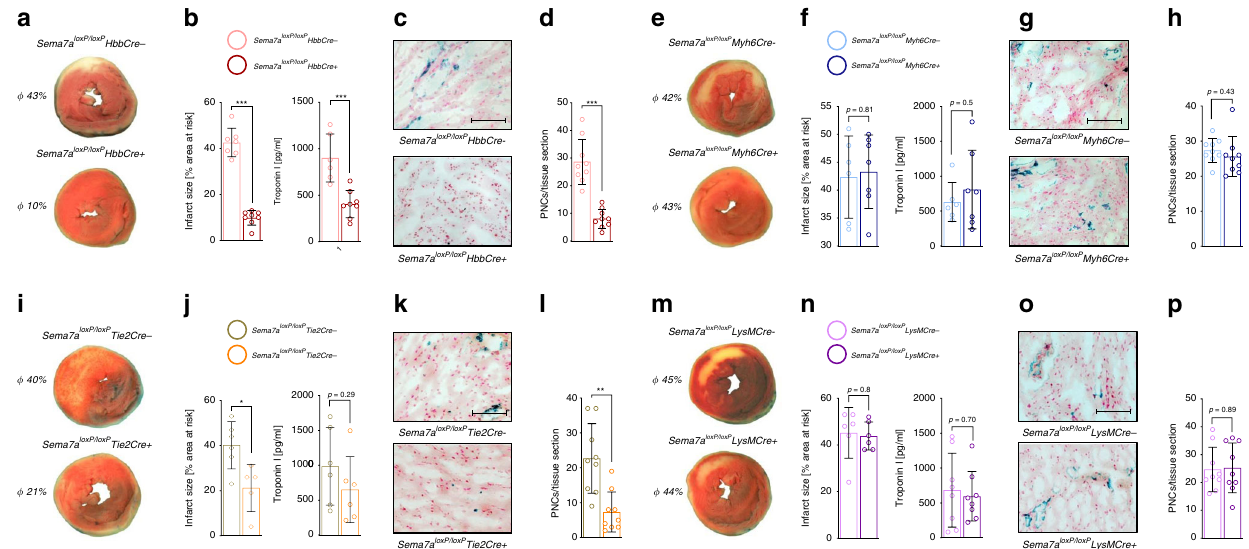
Fig. 4 RBC-derived Sema7a drives PNC formation and aggravates MIRI. Sema7a loxP/loxP HBBCre + , Sema7a loxP/loxP Myh6Cre + , Sema7a loxP/loxP Tie2Cre + , and Sema7a loxP/loxP LysMCre + animals or littermate controls were exposed to 60 min of ischemia and 120 min reperfusion. a Representative TTC-stained slices of myocardial tissue showing infarcted area (blue/dark = retrograde Evans blue staining; red and white = AAR, white = infarcted tissue) in Sema7a loxP/loxP HBBCre + or littermate controls with b systematic evaluation of infarct sizes ( n = 7;8) and correlating troponin I plasma levels ( n = 6;8). c Representative histology sections (scale bar 100 µ m) of Sema7a loxP/loxP HBBCre + animals or littermate controls and d number of PNCs counted from myocardial AAR sections in Sema7a loxP/loxP HBBCre + animals or littermate controls ( n = 9/group). e Representative TTC-stained slices of myocardial tissue showing infarcted area in Sema7a loxP/loxP Myh6Cre + or littermate controls with f systematic evaluation of infarct sizes and correlating troponin I plasma levels ( n = 6;7). g Representative histological sections of Sema7a loxP/loxP Myh6Cre + animals or littermate controls (scale bar 100 µ m) and h number of PNCs counted in myocardial tissue sections of Sema7a loxP/loxP Myh6Cre + animals or littermate controls ( n = 9/group). i Representative TTC-stained heart slices showing myocardial infarcts in Sema7a loxP/loxP Tie2Cre + or littermate controls with j systematic evaluation of infarct sizes ( n = 6;5) and correlating troponin I plasma levels ( n = 6;6). k Representative histology sections of Sema7a lox/loxP Tie2Cre + animals or littermate controls (scale bar 100 µ m) and l number of PNCs counted in myocardial tissue sections of Sema7a loxP/loxP Tie2Cre + or littermate controls ( n = 9/group). m Representative TTC-stained slices of myocardial tissue showing infarcted area in Sema7a loxP/loxP LysMCre + or littermate controls with n systematic evaluation of infarct sizes ( n = 6/group) and correlating troponin I plasma levels ( n = 8/group). o Representative histology sections of Sema7a loxP/loxP LysMCre + animals or littermate controls (scale bar 100 µ m) and p number of PNCs counted from myocardial tissue sections of Sema7a loxP/loxP LysMCre + or littermate controls ( n = 9/group). All comparisons in this fi gure were analyzed by unpaired two-tailed Student ’ s t -tests (data are mean ± SD). * p < 0.05, ** p < 0.01 and *** p < 0.001 as by the human IL-4 receptor ( GPIb-IL-4tg ) (Fig. 5c, d), where thrombus volume in the whole-blood perfusion system.